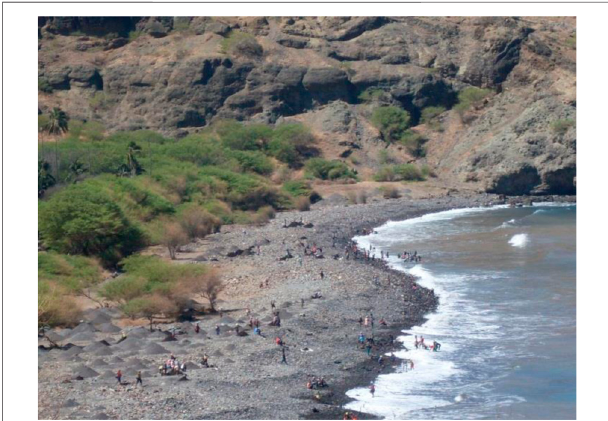
FIGURE 3 | Sand harvesting, Djangago Beach/Charco. Source: Images taken by the researchers, March